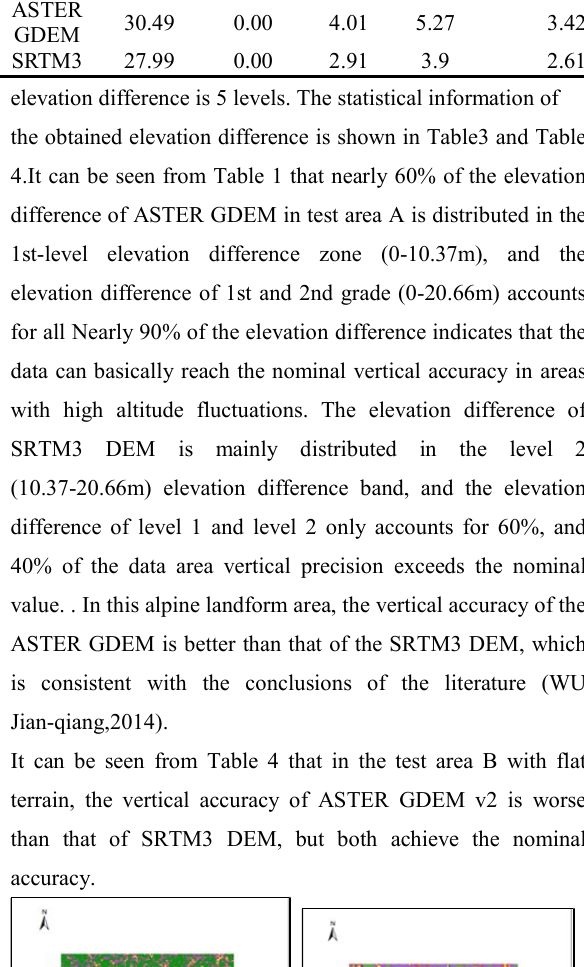
Figure 5 Slope spectrum of three DEMs in test area A